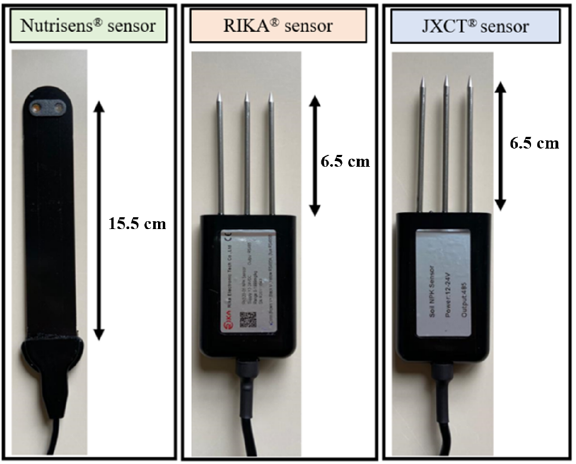
Figure 1. Picture of the sensors used in the study: Nutrisens, Rika and JXCT.